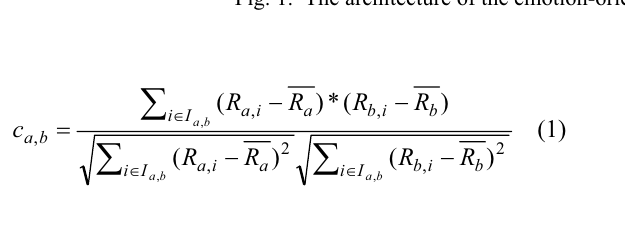
Fig. 1. The architecture of the emotion-oriented music recommendation